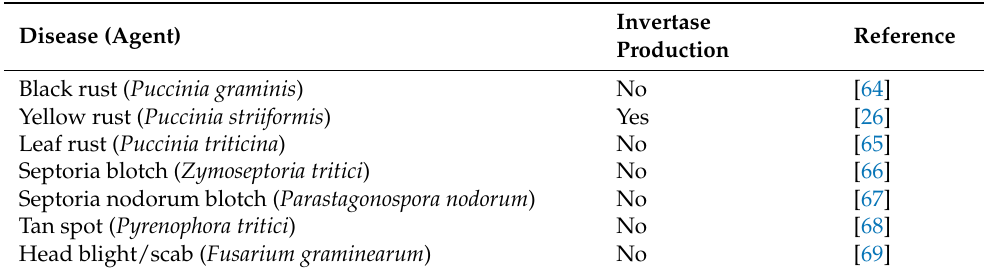
Table 2. List of common wheat diseases and their agents, indicating invertase production based on their genomic make-up.